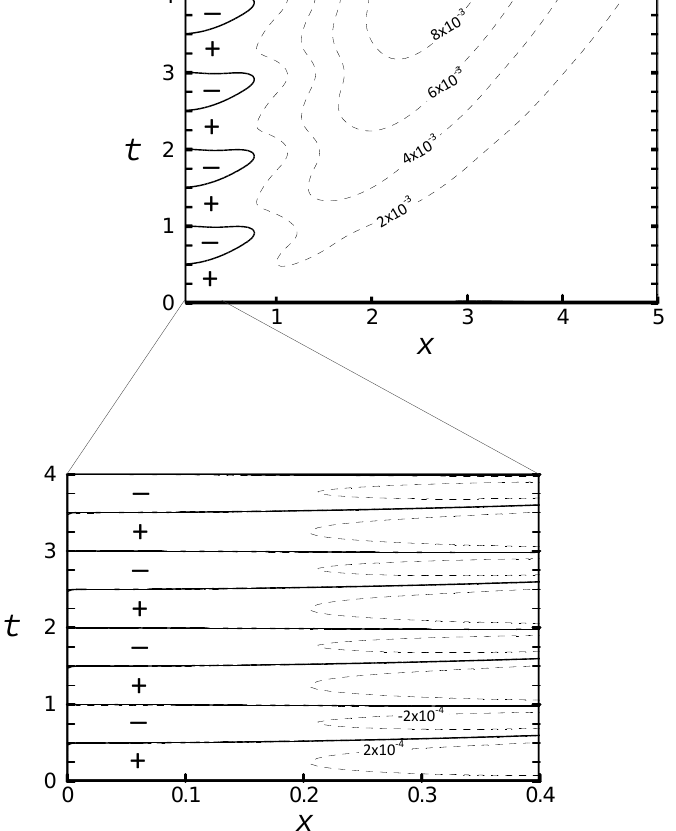
Figure 7. Contours of the surface velocity u | solid contour represents the zero contour, i.e., stagnation points.